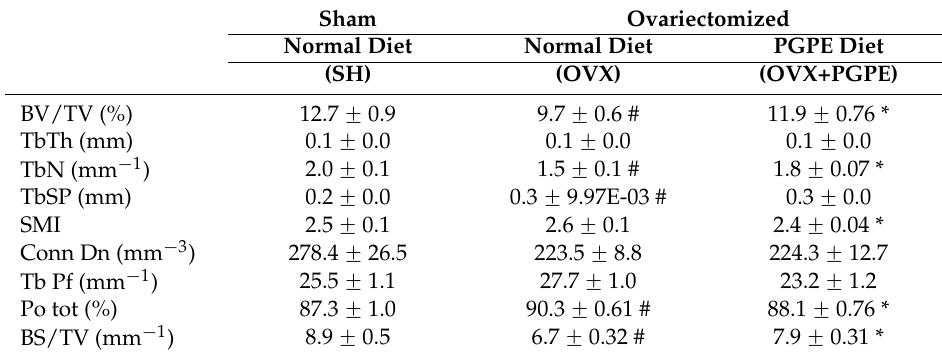
Table 2. Effect of ovariectomy and pomegranate peel extract consumption for 30 days on bone micro-architectural parameters in mice. Sham Ovariectomized Normal Diet Normal